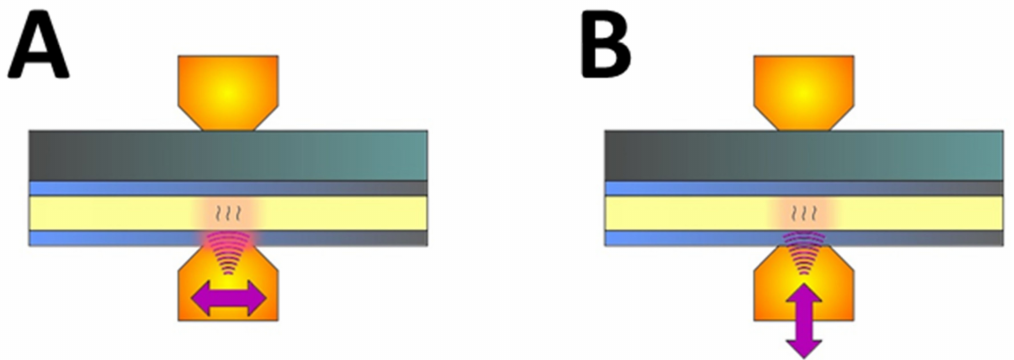
Figure 4. The two analyzed vibrating systems: ( A ) transverse, ( B )